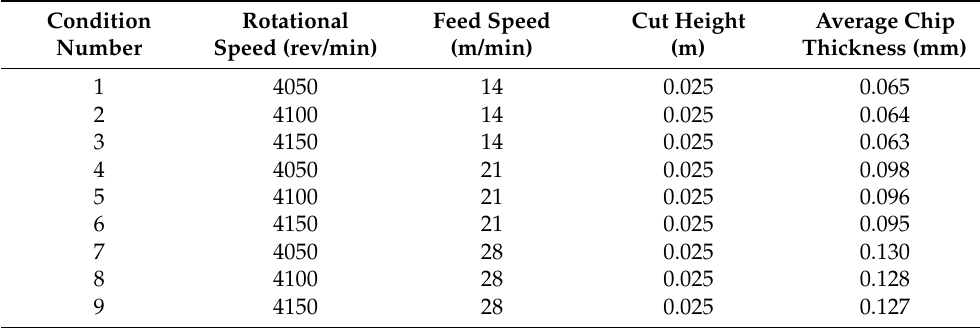
Table 2. Rotational speed, feed speed, and cut height for the nine cutting conditions. Also listed is the corresponding average chip thickness.